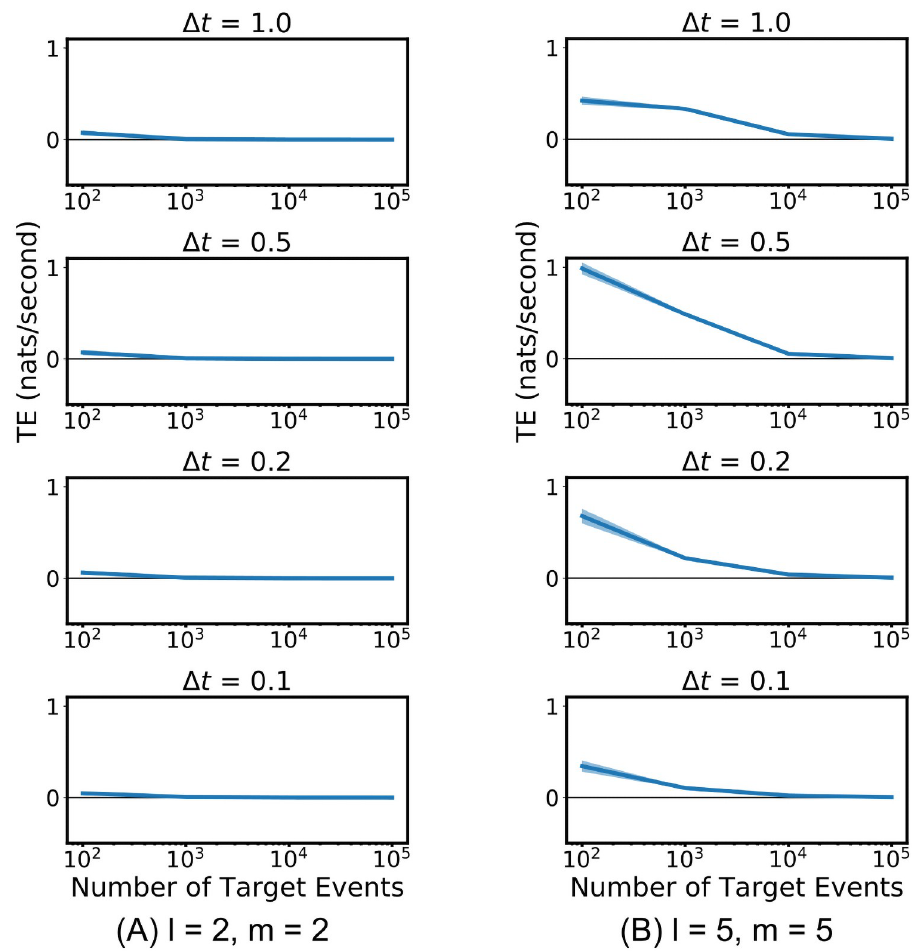
Fig 3. Result of the discrete-time estimator applied to independent homogeneous Poisson processes. The solid line shows the average TE rate across multiple runs and the shaded area spans from one standard deviation below the mean to one standard deviation above it. Plots are shown for four different values of the bin width Δ t as well as different source and target embedding lengths, l and m